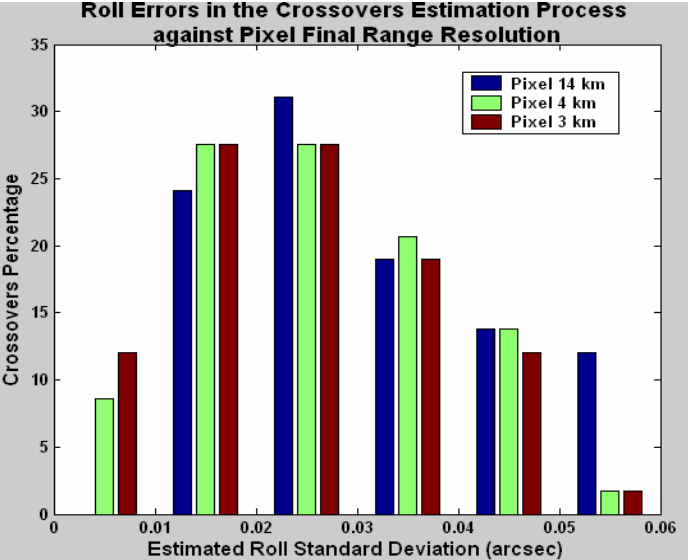
Figure 18. Influence of the pixel range resolution on the quality of the estimation